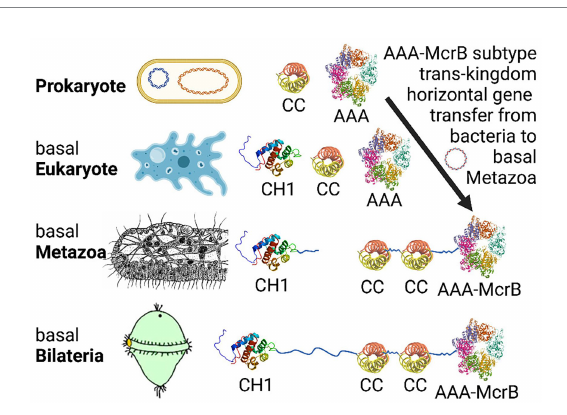
FIGURE 5 Proposed evolutionary history of bilaterian NAVs by domain recombination. The CC and AAA+ domains appear already in prokaryotes, while CH domains first appear and are ubiquitous among eukaryotes. The AAA + -McrB subtype was either lost from plants, or moved from bacteria to basal Metazoa by “trans- kingdom horizontal gene transfer” (Iyer et al., 2004), perhaps after feeding-related consumption. The C-terminal precursor region of NAVs (consisting of linked CC1, CC2, and AAA+ domains) was assembled in basal Metazoa, as indicated by the structure of the Trichoplax sp. H2 NAV2-like protein. Finally, the N-terminal precursor region containing the CH1 domain (and SxIP motifs, not shown) was fused with the C-terminal precursor to form canonical NAVs in basal Bilateria. Interestingly, loss of the CH domain from NAV1, thought to have occurred after gene duplication in the lineage to vertebrates (Maes et al., 2002), makes NAV1 resemble the NAV-like C-terminal precursor as observed in Trichoplax . Figure produced using